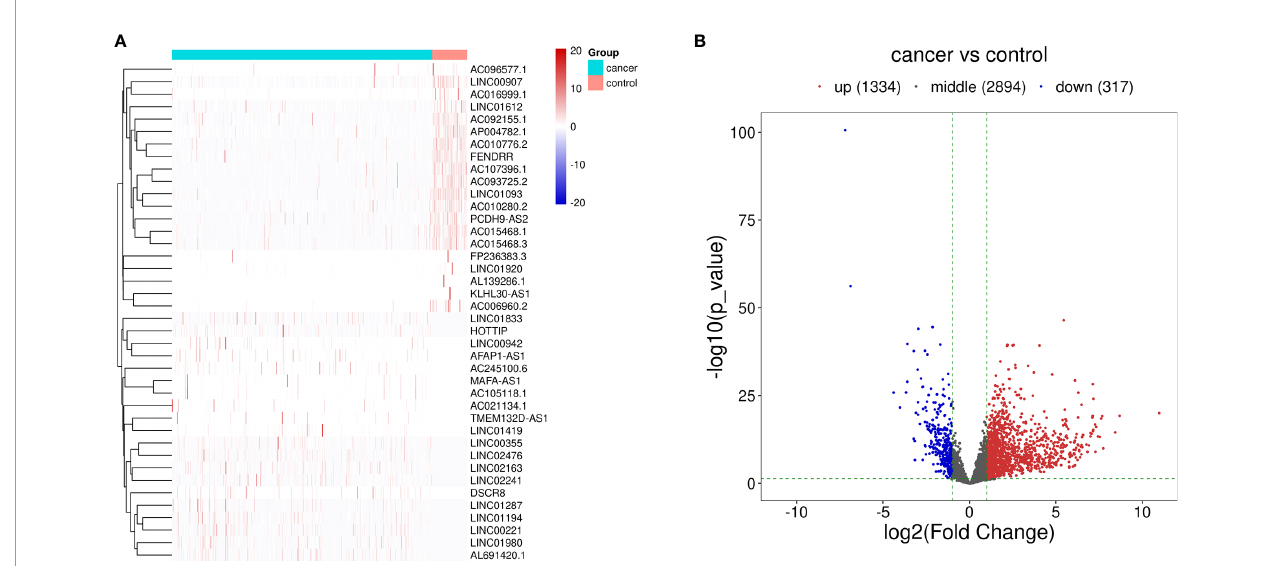
FIGURE 2 | Differentially expressed lncRNAs between HCC cases and control cases. (A) Hierarchical clustering of the differentially expressed lncRNAs. The blue bar represents the cancer cases, and red bar represents the control cases. (B) Volcano map of the differentially expressed lncRNAs. Red dots represent the upregulated lncRNAs and blue dots represent the downregulated lncRNAs.